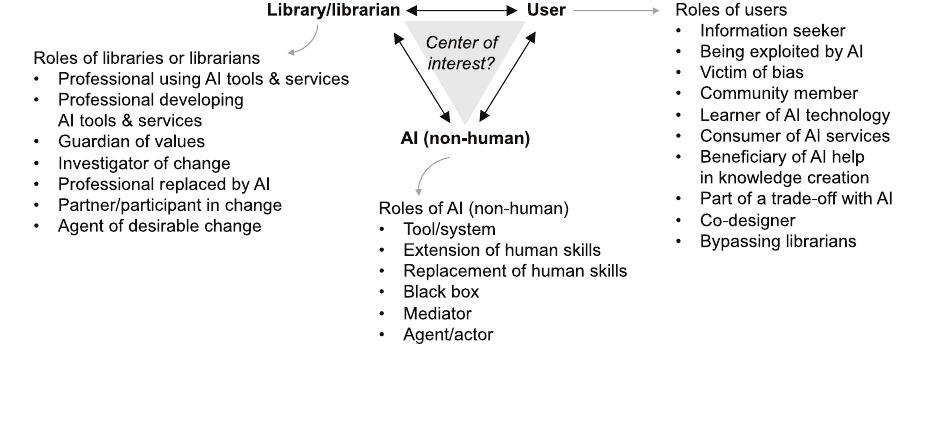
Fig. 3: Diversity of roles indicates the shifting center of